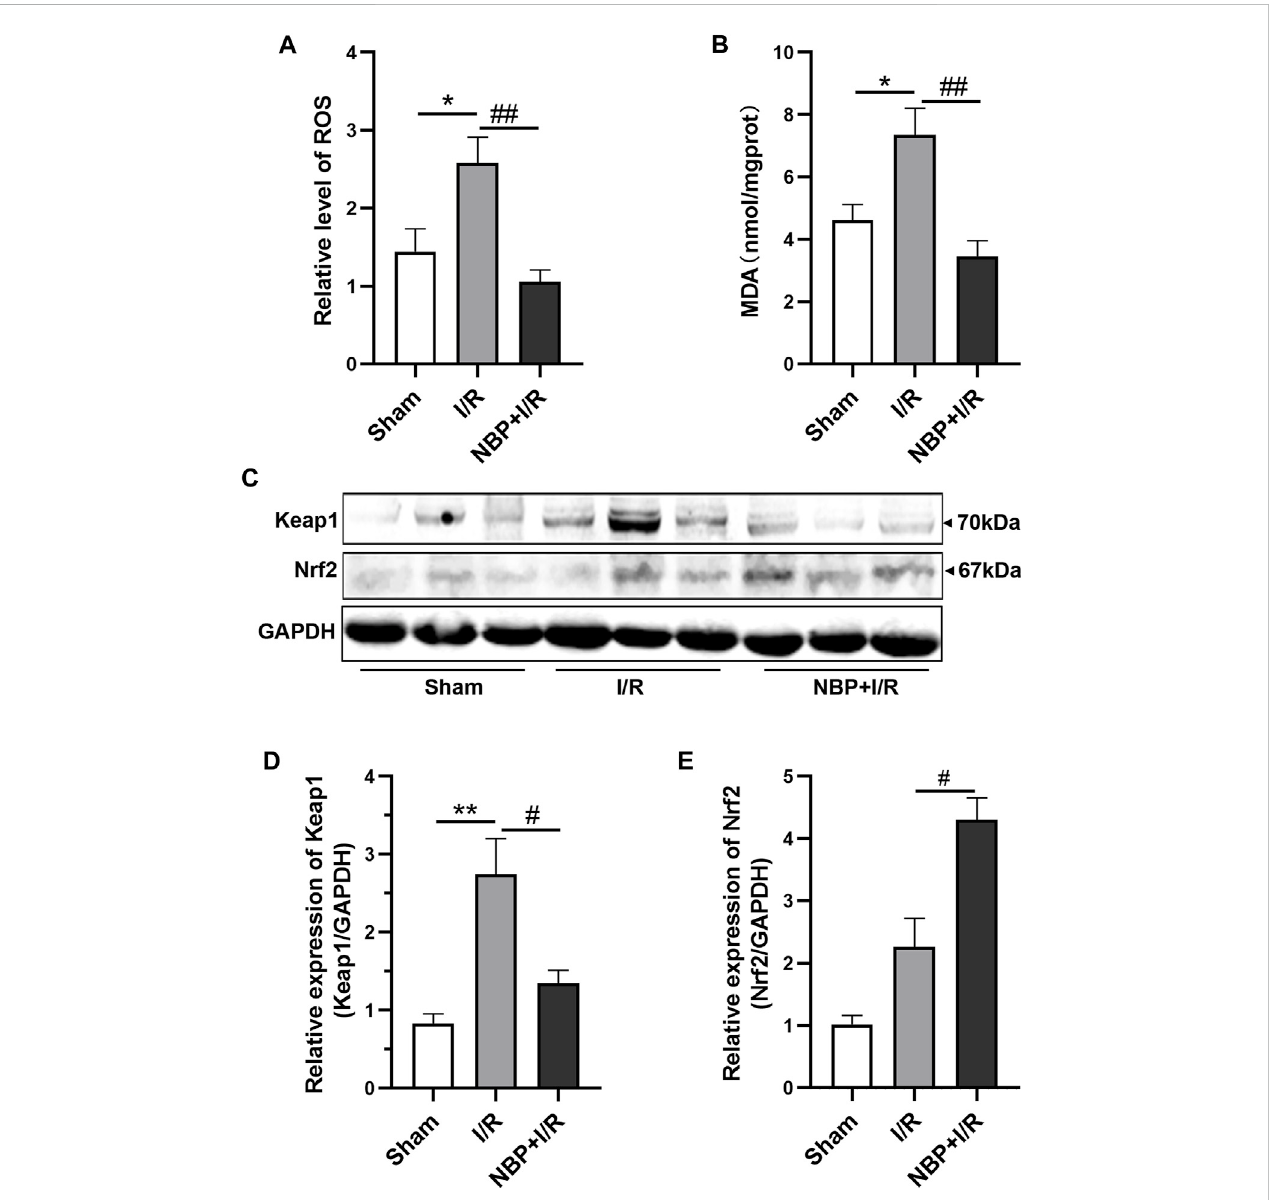
EffectsofNBPonoxidativestressintheinfarctedcerebralhemisphereinI/Rrats. (AandB) EffectsofNBPonROSlevelsandMDAleves(n=6).I/Rsurgery signi fi cantly elevated ROS levels and MDA levels, while NBP signi fi cantly decreased ROS levels and MDA levels in I/R rats. (C – E) Effects of NBP on Keap1/ Nrf2 pathway (n = 3). NBP signi fi cantly downregulated Keap1 expression and upregulated Nrf2 expression in I/R rats. Data are expressed as the mean ± SEM and were analyzed by one-way ANOVA ( post hoc analysis: Tukey ’ s post hoc analysis test). * ( p < .05) and ** ( p < .01) represent signi fi cance compared to the sham group. # ( p < .05) and ## ( p < .01) represent signi fi cance compared to the I/R group ( p < .01). NBP dose: NBP + I/R, 9